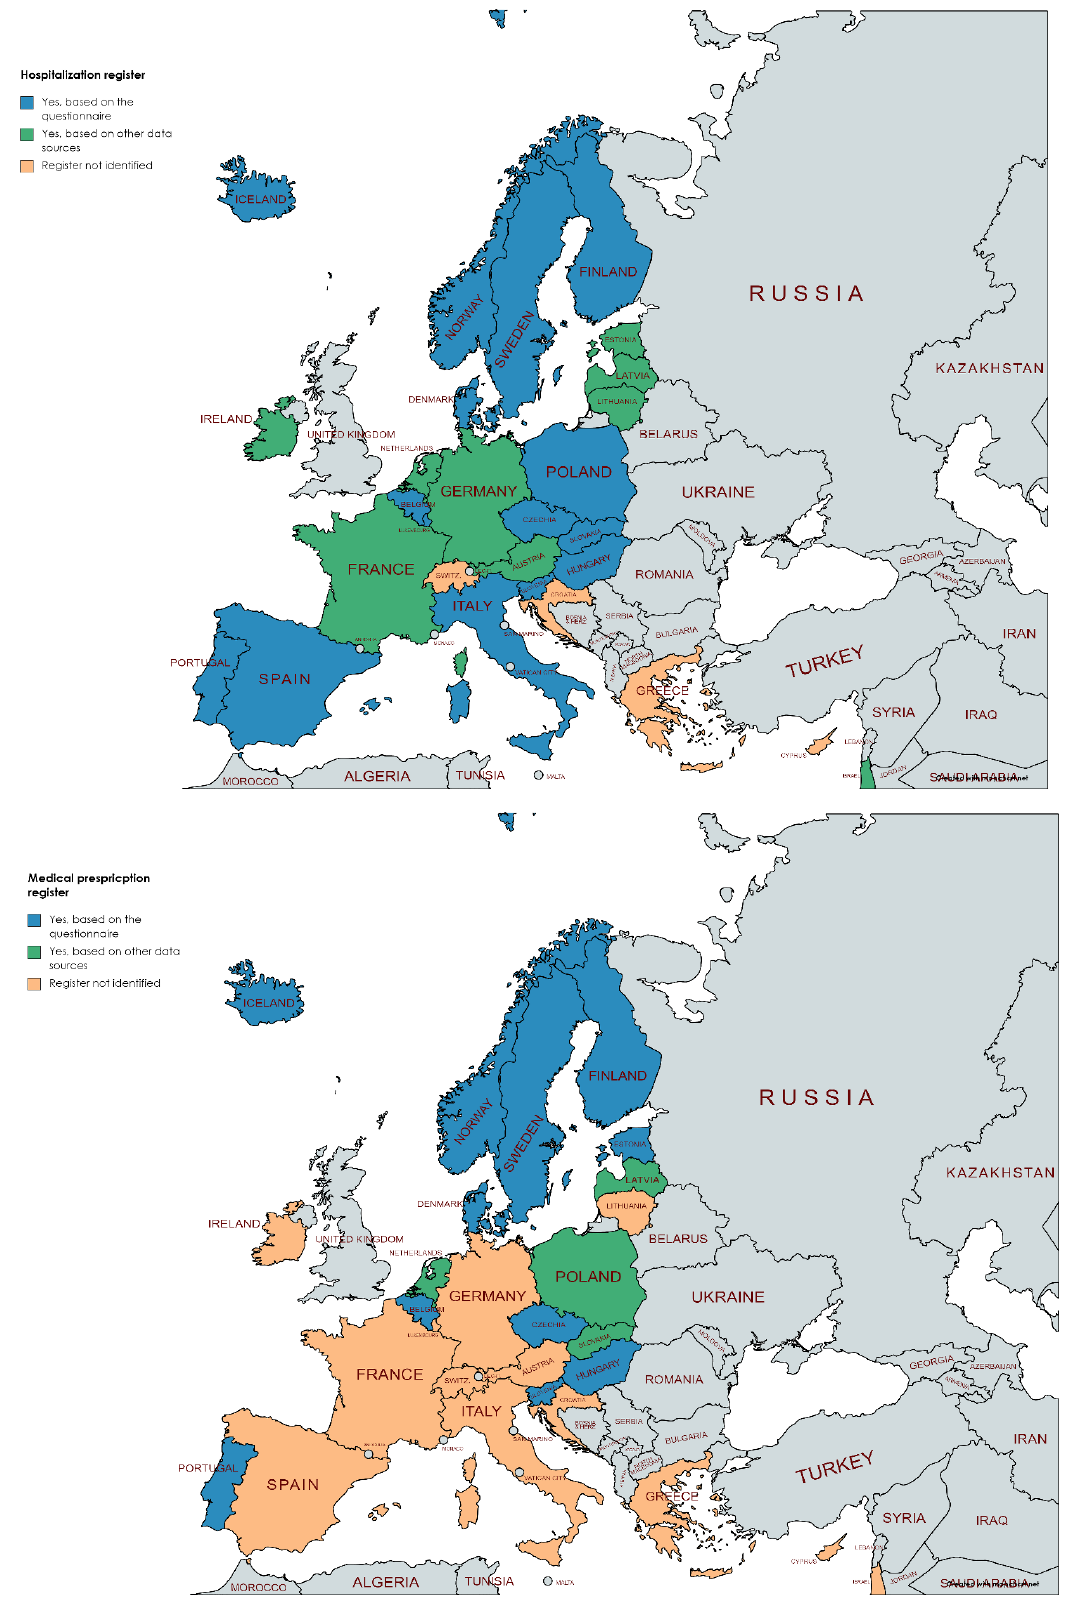
Figure 4. Availability of register of hospitalizations and medical prescriptions (blue = provided by the National Hub contact points, green = obtained from other data sources as described in the Section 2). Figure has been created using MapChart.net web tool.